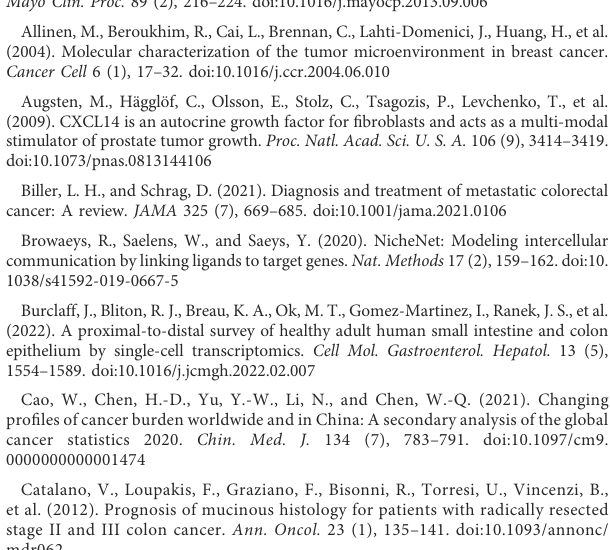
SUPPLEMENTARY FIGURE S1 (A) Immune cell subcluster and proportion in human colorectal adenocarcinoma not otherwise speci fi ed, mucinous adenocarcinoma, and normal colon. (B) Bar plots showing the signi fi cance of different immune cell proportions that differed in two types of colorectal adenocarcinomas and normal colon. (C) Bar plots showing the signi fi cance of different immune cell proportions that differ in two types of colorectal adenocarcinoma. SUPPLEMENTARY FIGURE S2 (A) GO enrichment of top ligands from colorectal adenocarcinoma